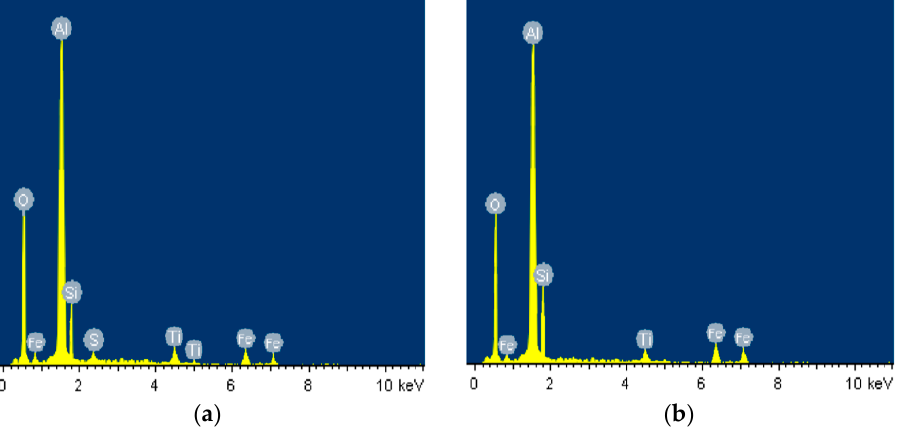
Figure 12. EDS analysis of ( a ) area 1 and ( b ) area 2. The elemental analysis results of area 1 and area 2 by EDS are shown in Table 5. Table 5. Elemental analysis results of area 1 and area 2.